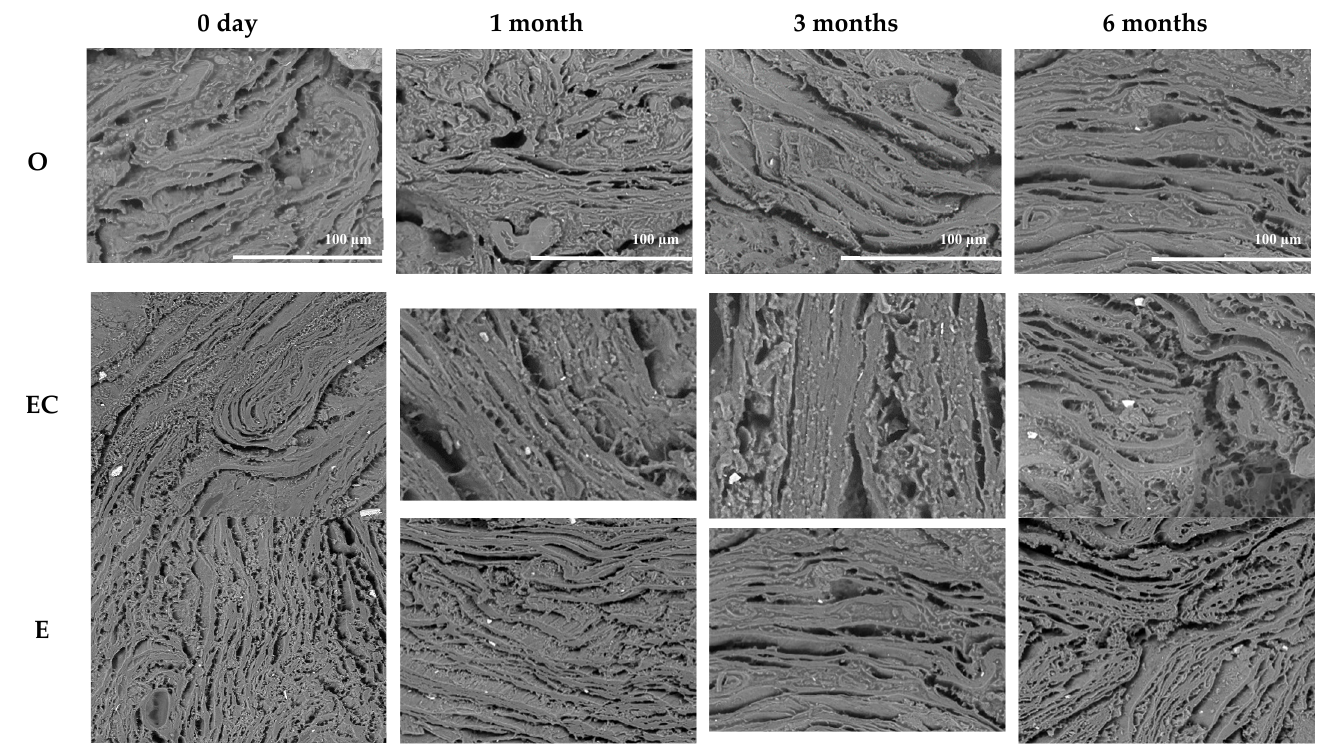
Figure 2. Microstructure of meat analogs with different fat replacers (O, EC, and E) during the freez- ing storage ( − 18 °C) for six months (500).